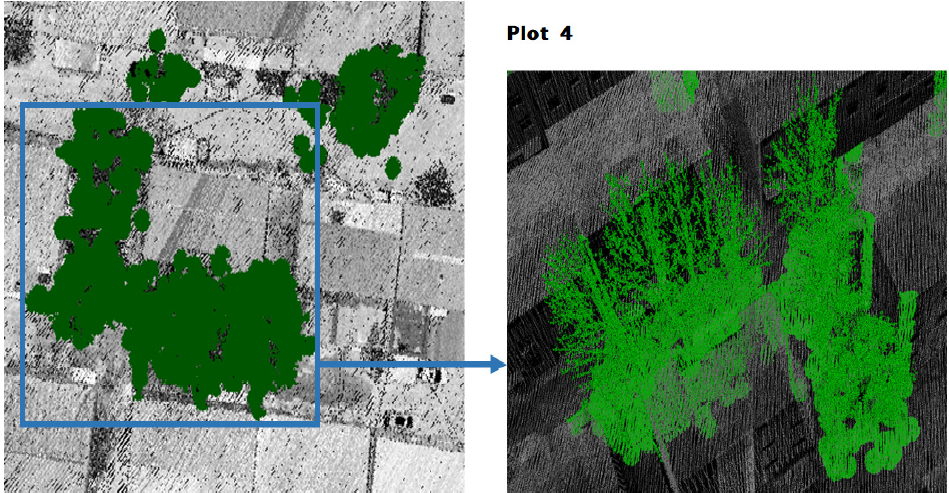
Figure 12. Trees extracted in complex scenes (green points).